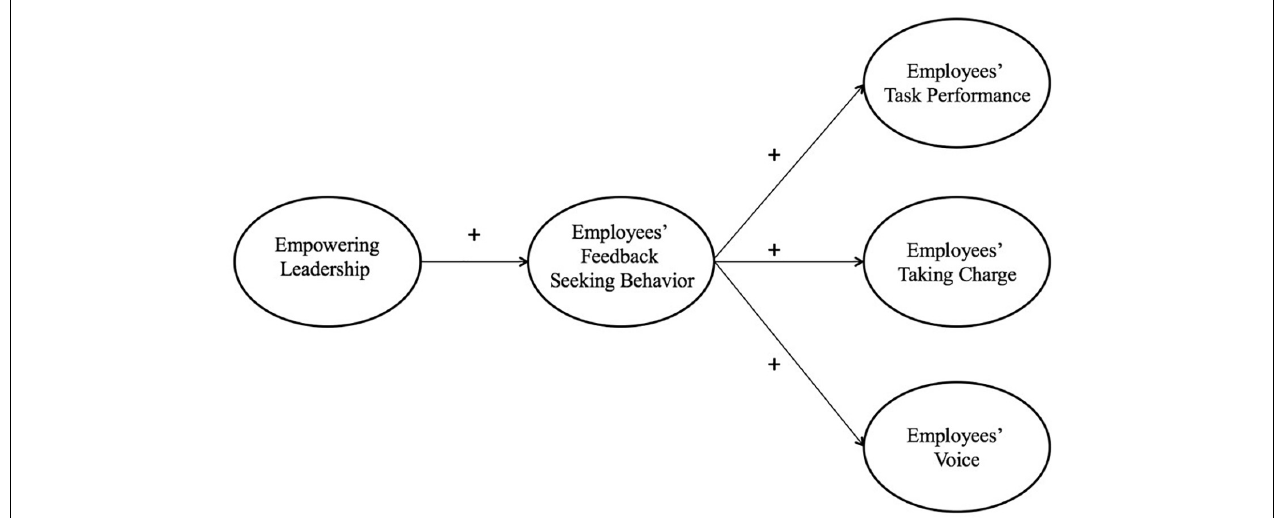
FIGURE 1 | Theoretical